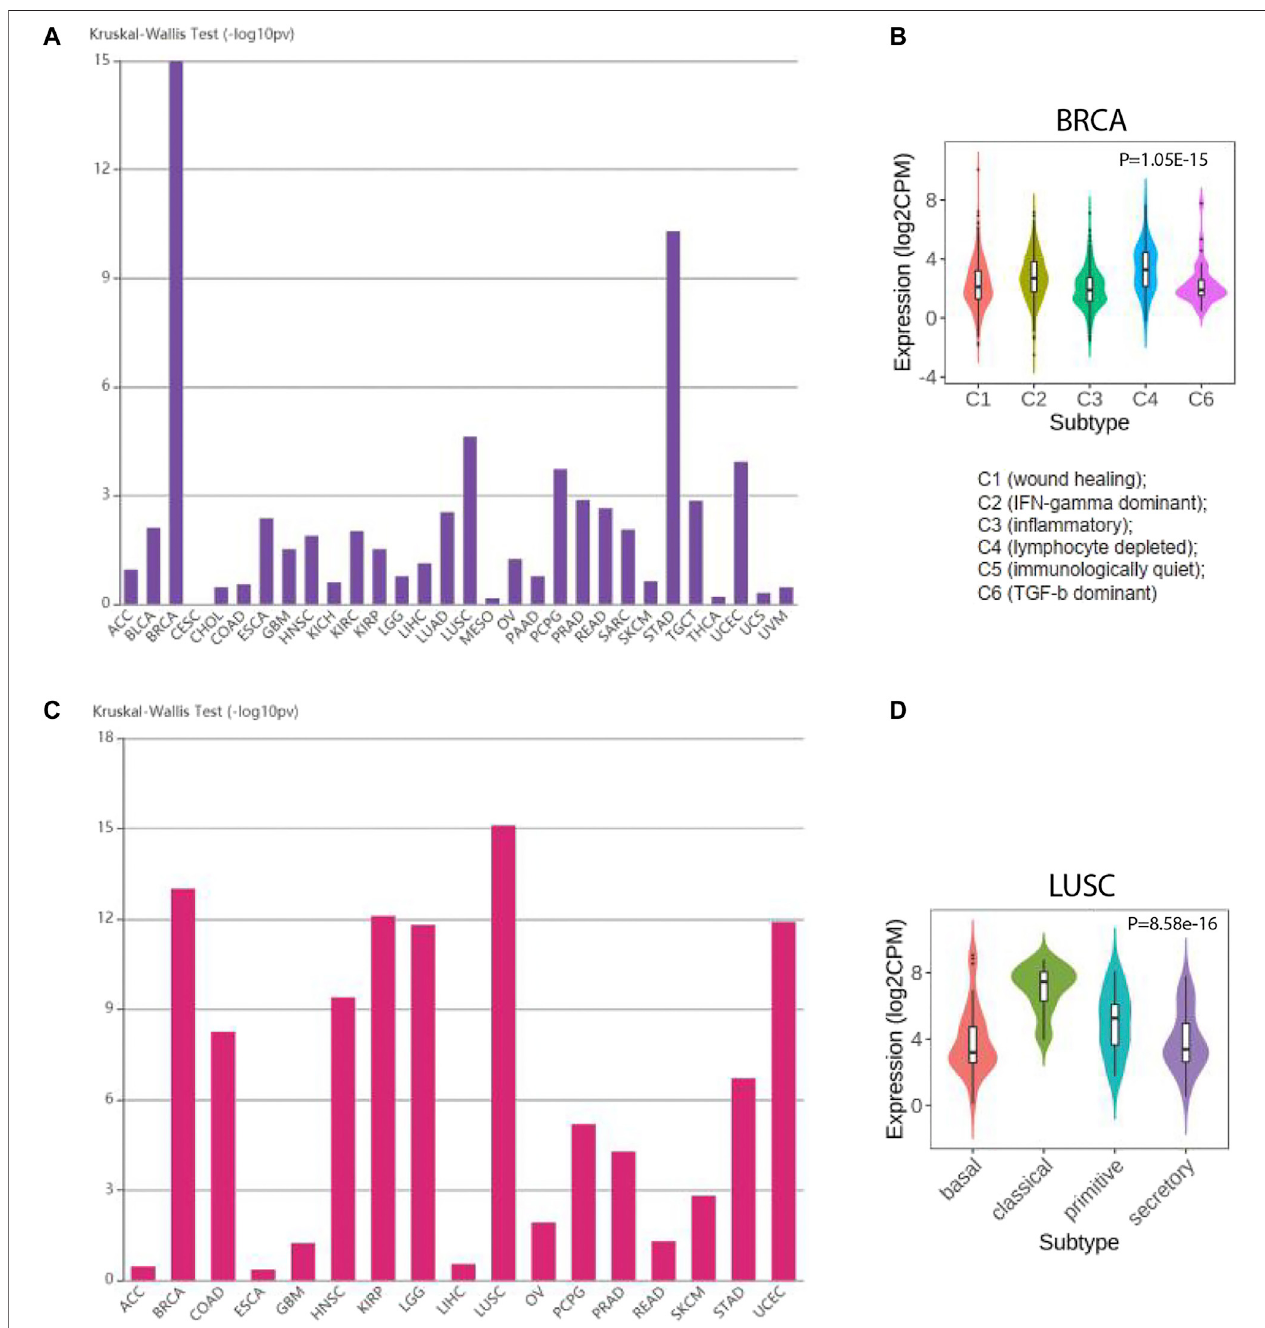
FIGURE 6 | The expression of SLC7A11 is altered in different molecular and immune subtypes of cancers. (A, B) SLC7A11 expression in distinct molecular subtypes for cancers. (C, D) SLC7A11 expression in distinct immune subtypes for cancers.